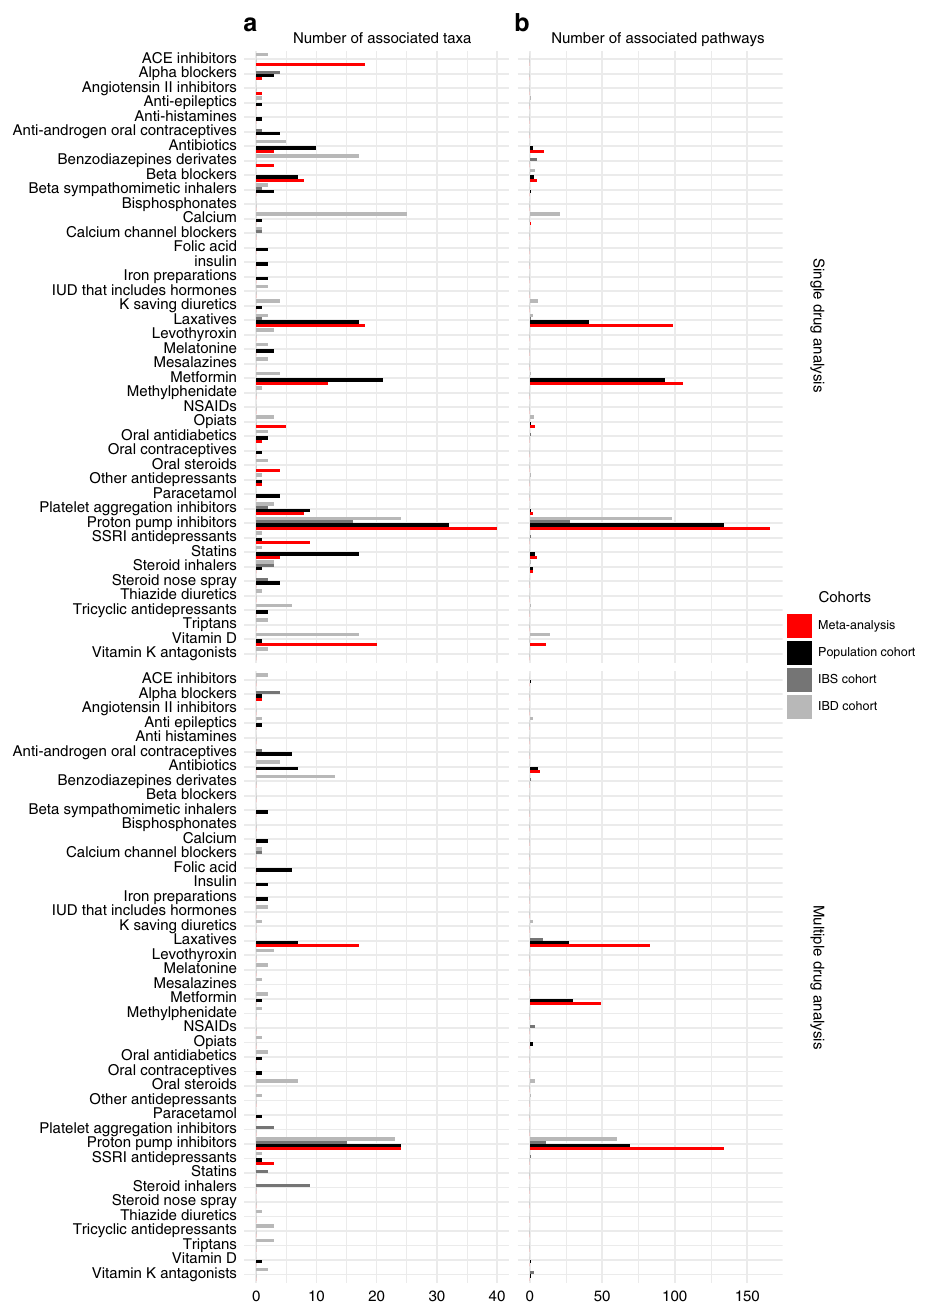
Fig. 2 Overview of the number of associated microbial features. a , b Bar-plots showing the number of associations between each type of drug and microbial taxa a and microbial pathways b . Bar colours indicate the results from the separate cohorts and the results from the meta-analyses. Black bars indicate the population cohort, dark grey bars the IBS cohort, light grey bars the IBD cohort and red bars the results from the meta-analyses. The single- drug model shows the association when considering one drug at the time while taking age, sex and BMI into account. The multi-drug model considers the use of multiple drug types while taking age, sex and BMI into account. (Source data are provided as a Source Data fi